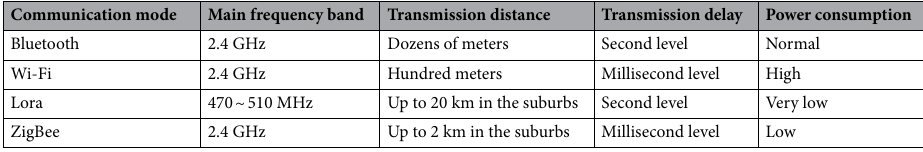
Table 1. Performance comparison of various communication